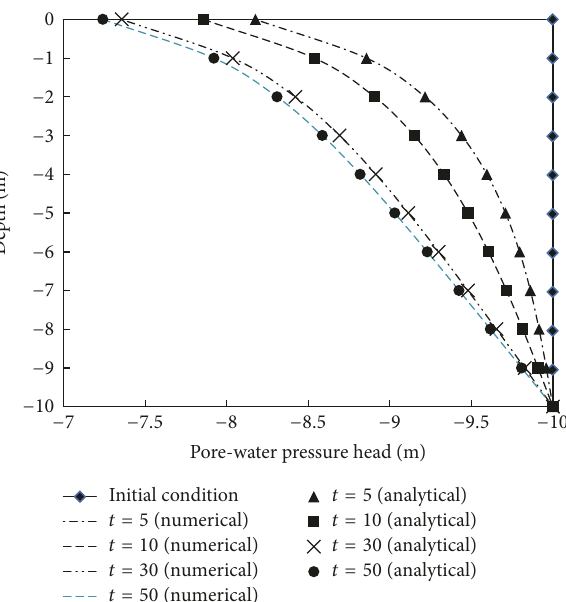
Figure 3: A comparison between the numerical and analytical solution to the 1D coupled infiltration